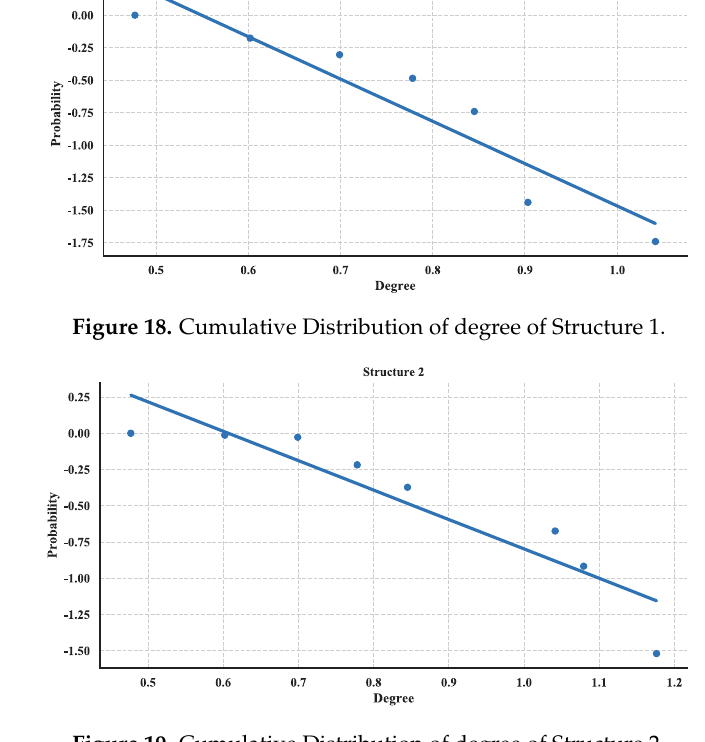
Figure 19. Cumulative Distribution of degree of Structure 2.